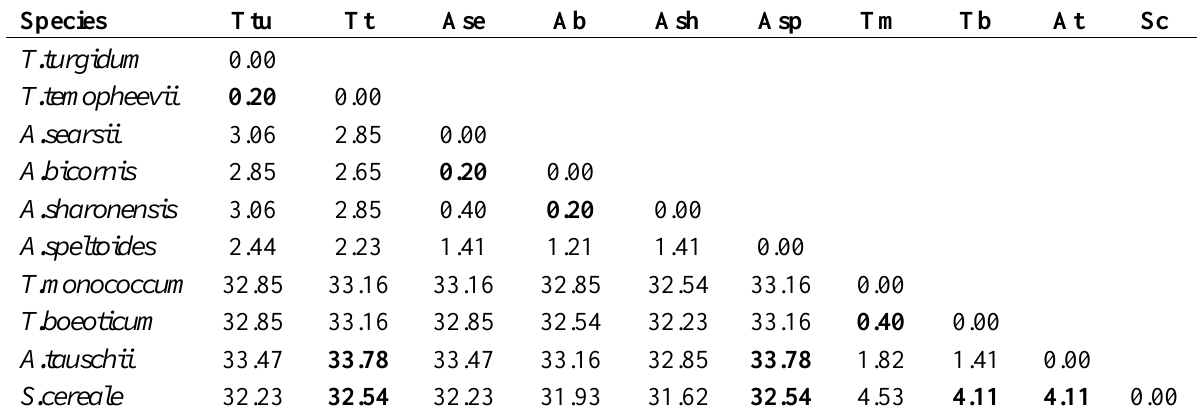
Table 4. DNA distances among Triticum and Aegilops species (1000 trials). Distance Matrix was calculated using the Jukes-Cantor correction method. Base positions 123 in the codon and gap weighting 0.0 were